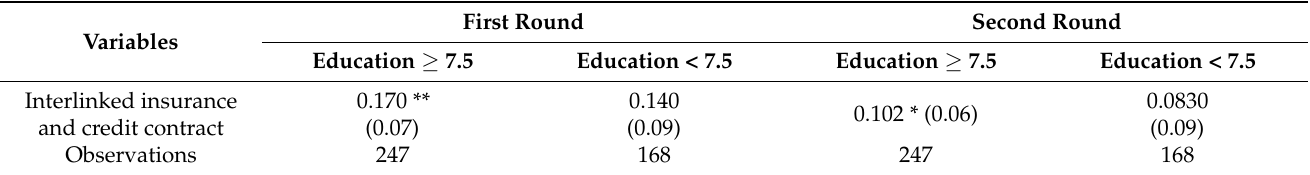
Table 9. Interlinked insurance and credit contract and farmers’ adoption of innovative seeds.